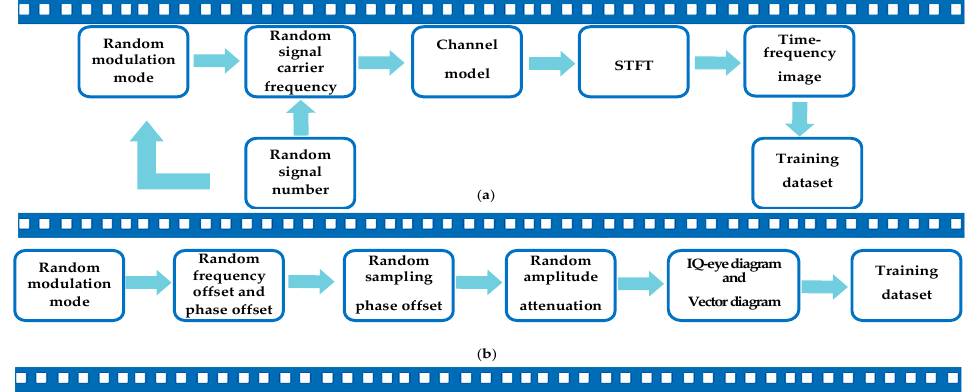
Figure 3. The generation processing of the dataset. ( a ) dataset for signal detection; ( b ) dataset for modulation recognition .